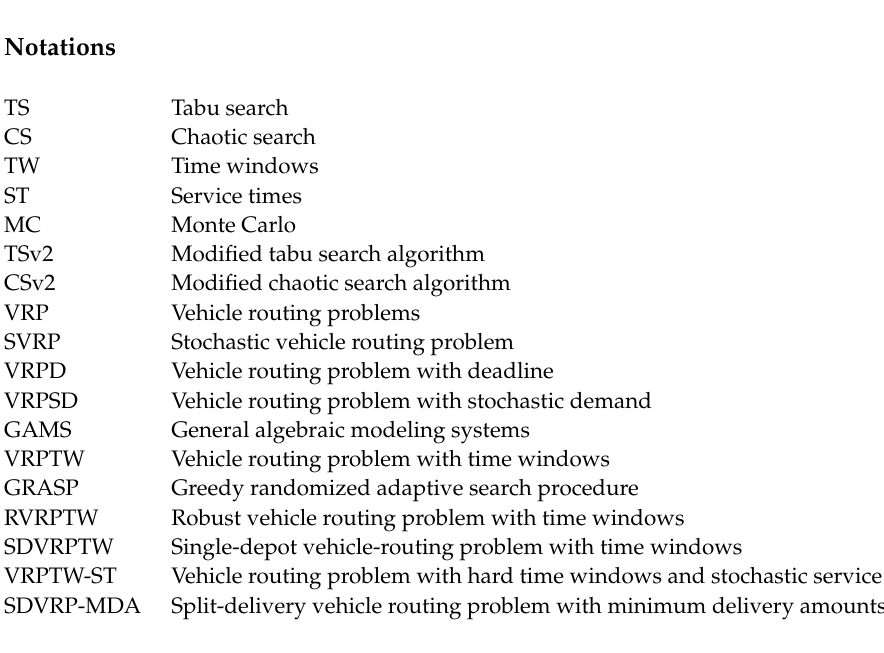
for the CS method with α = 0.5 according to the confidence levels β and γ , and percentage of supermarkets, Table S4: Averages of the execution time, amount of trucks, and distance obtained for the CSv2 method with α = 0.5 according to the confidence levels β and γ , and percentage of